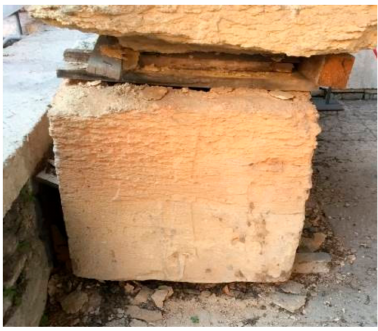
Figure 5. The tomb of the Order of the Temple discovered in